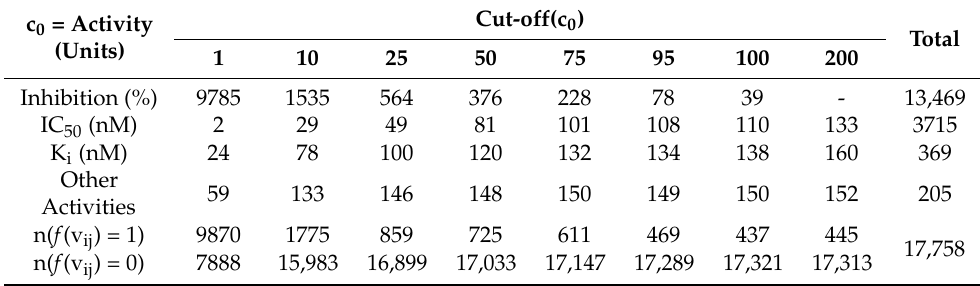
Table 2. Selected values of multi-condition averages for different combinations of assay